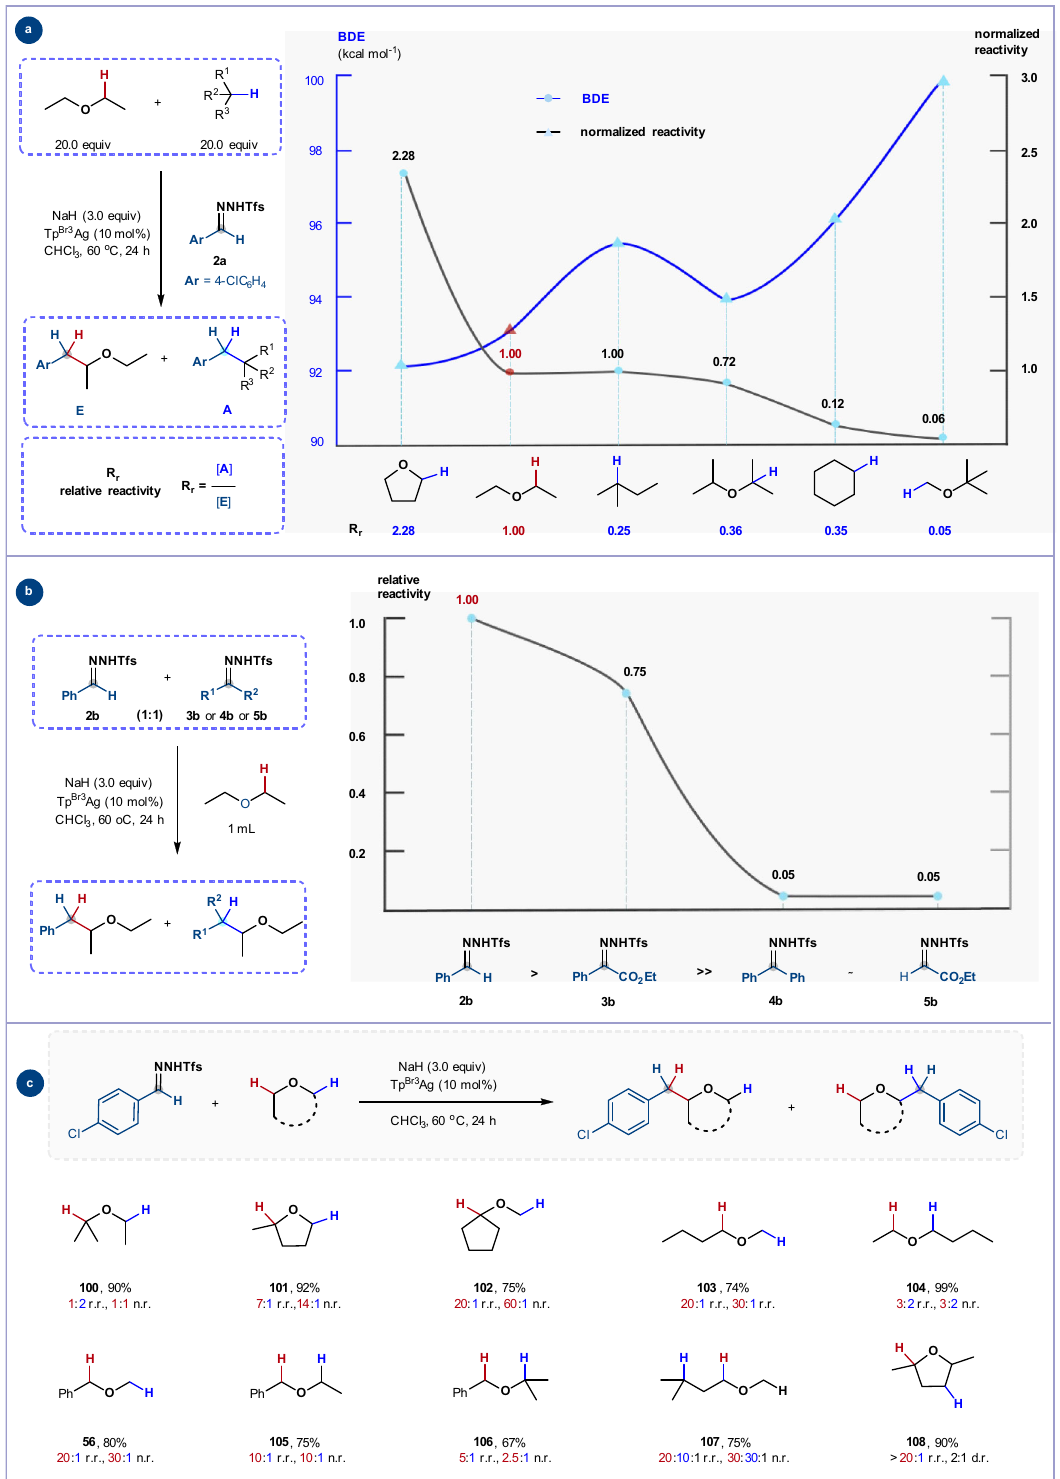
Fig. 7 Investigation on relative reactivity and site-selectivity of C(sp 3 ) – H bonds with donor silver carbenes. a Relative reactivities of C(sp 3 ) – H bonds towards the donor silver carbene derived from 2a . b Relative reactivities of different silver carbenes towards ether α -C – H bonds. c Site-selectivity investigation of C(sp 3 ) – H bonds with subtle electronic and steric differences adjacent to ether oxygen. r.r., regioisomeric ratio; n.r., normalized regioselectivity; d.r., diastereomeric